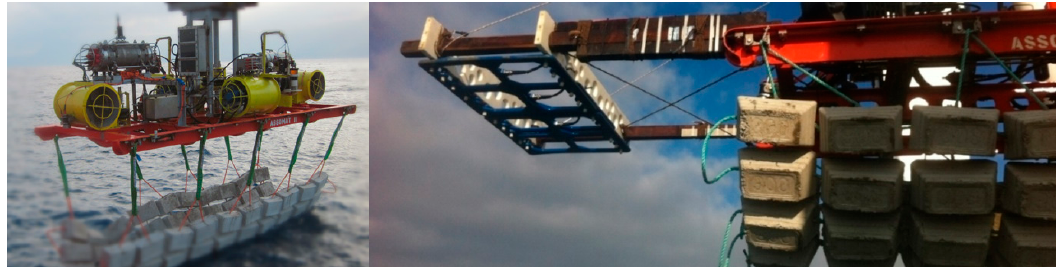
Figure 17. Assomat II used in the Lâpseki–Sütlüce installation.